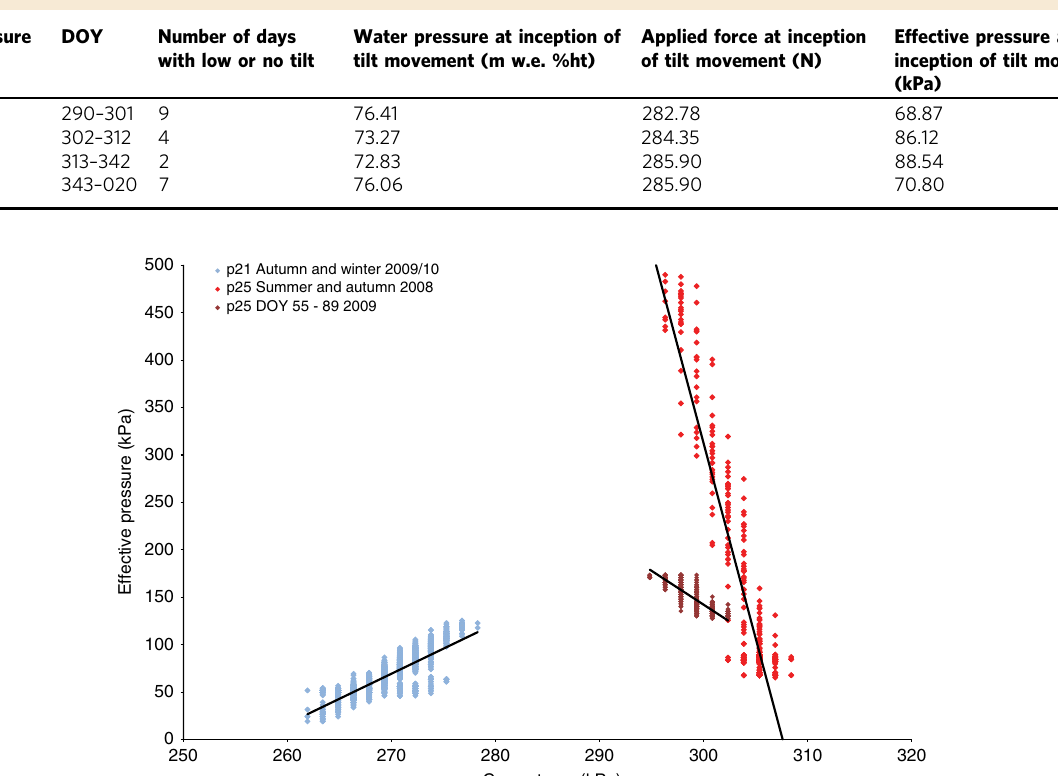
Fig. 7 Graph showing the relationship between case strain (till strength) and water pressure for the subglacial probes (2008 – 2010 data)